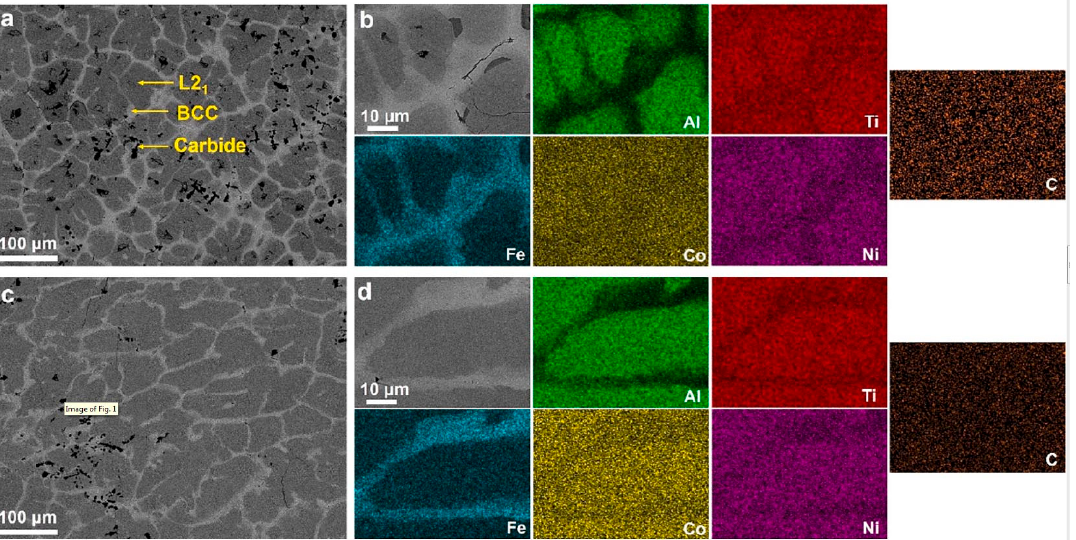
Figure 9. SEM micrographs and EDS mappings of AlTiFeCoNi-0.45%C ( a , b ) before and ( c , d ) after HPT processing. Reprinted with permission from Ref. [129]. Copyright 2021 Elsevier.